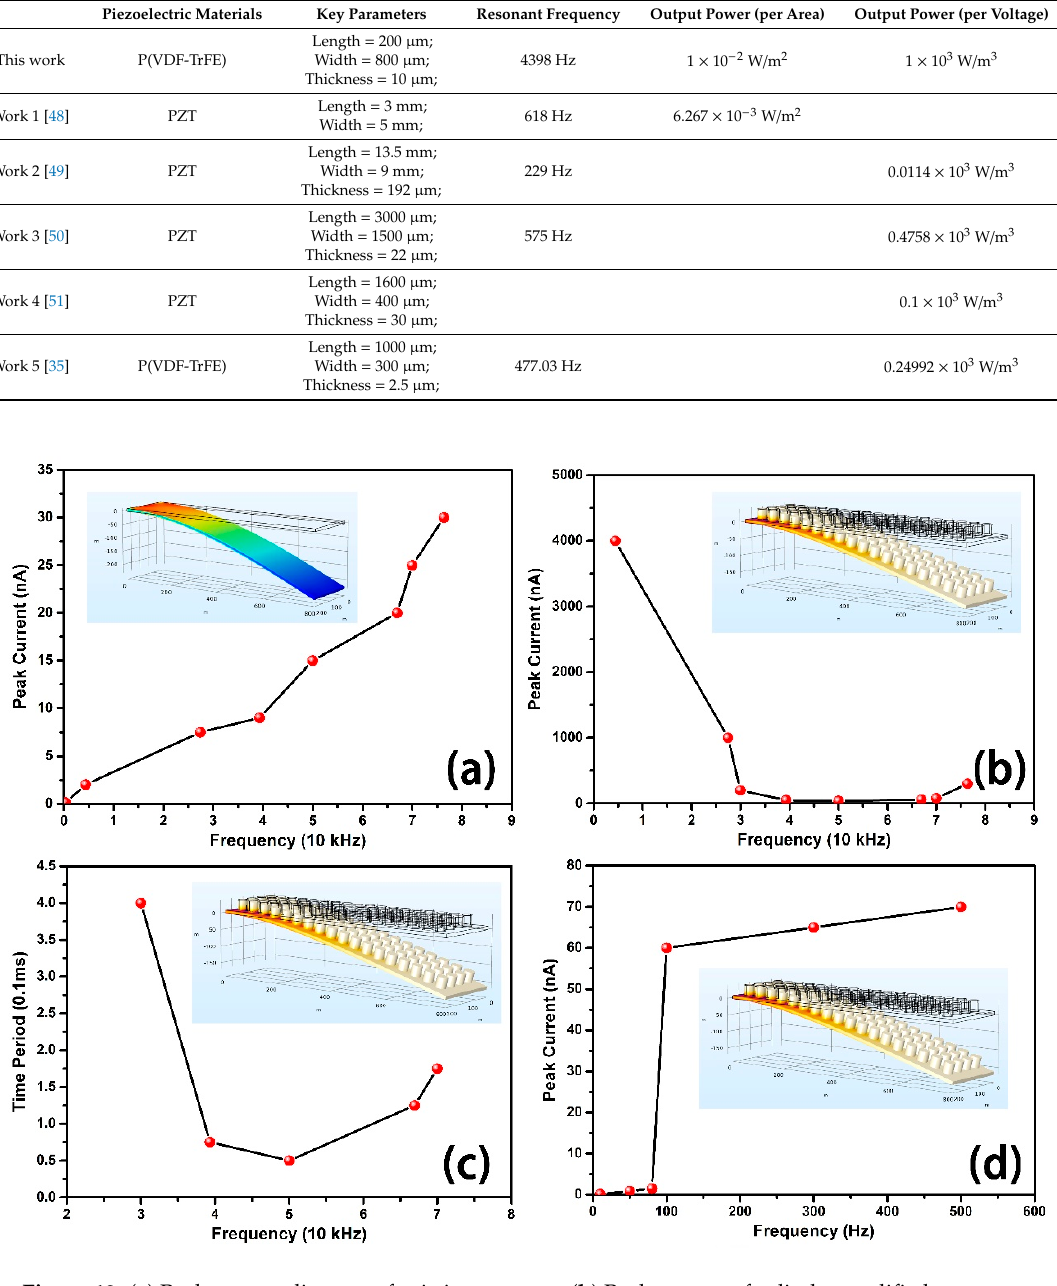
Figure 10. ( a ) Peak current diagram of pristine structure ( b ) Peak current of cylinder modified structure ( c ) Big period value of the cylinder modified structure. All the red points above are simulation results and black lines are the fitting curve. ( d ) Peak current of low frequency.